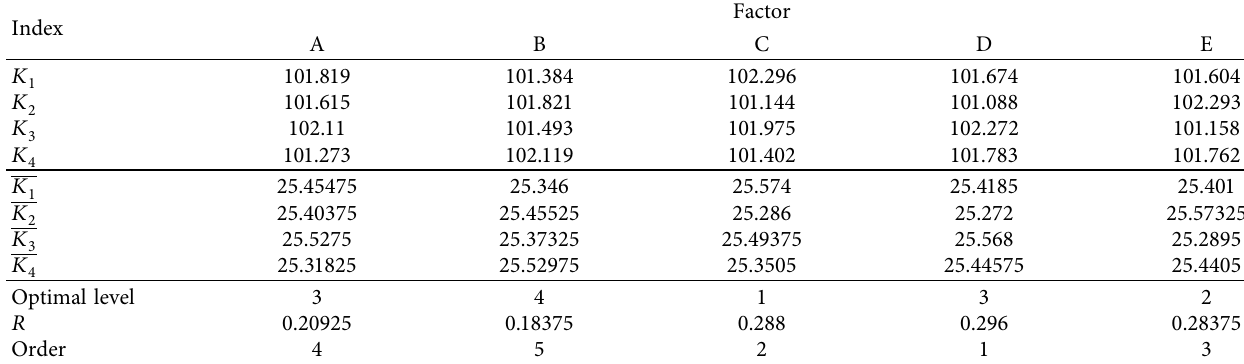
Table 6: Extreme diference analysis of head.